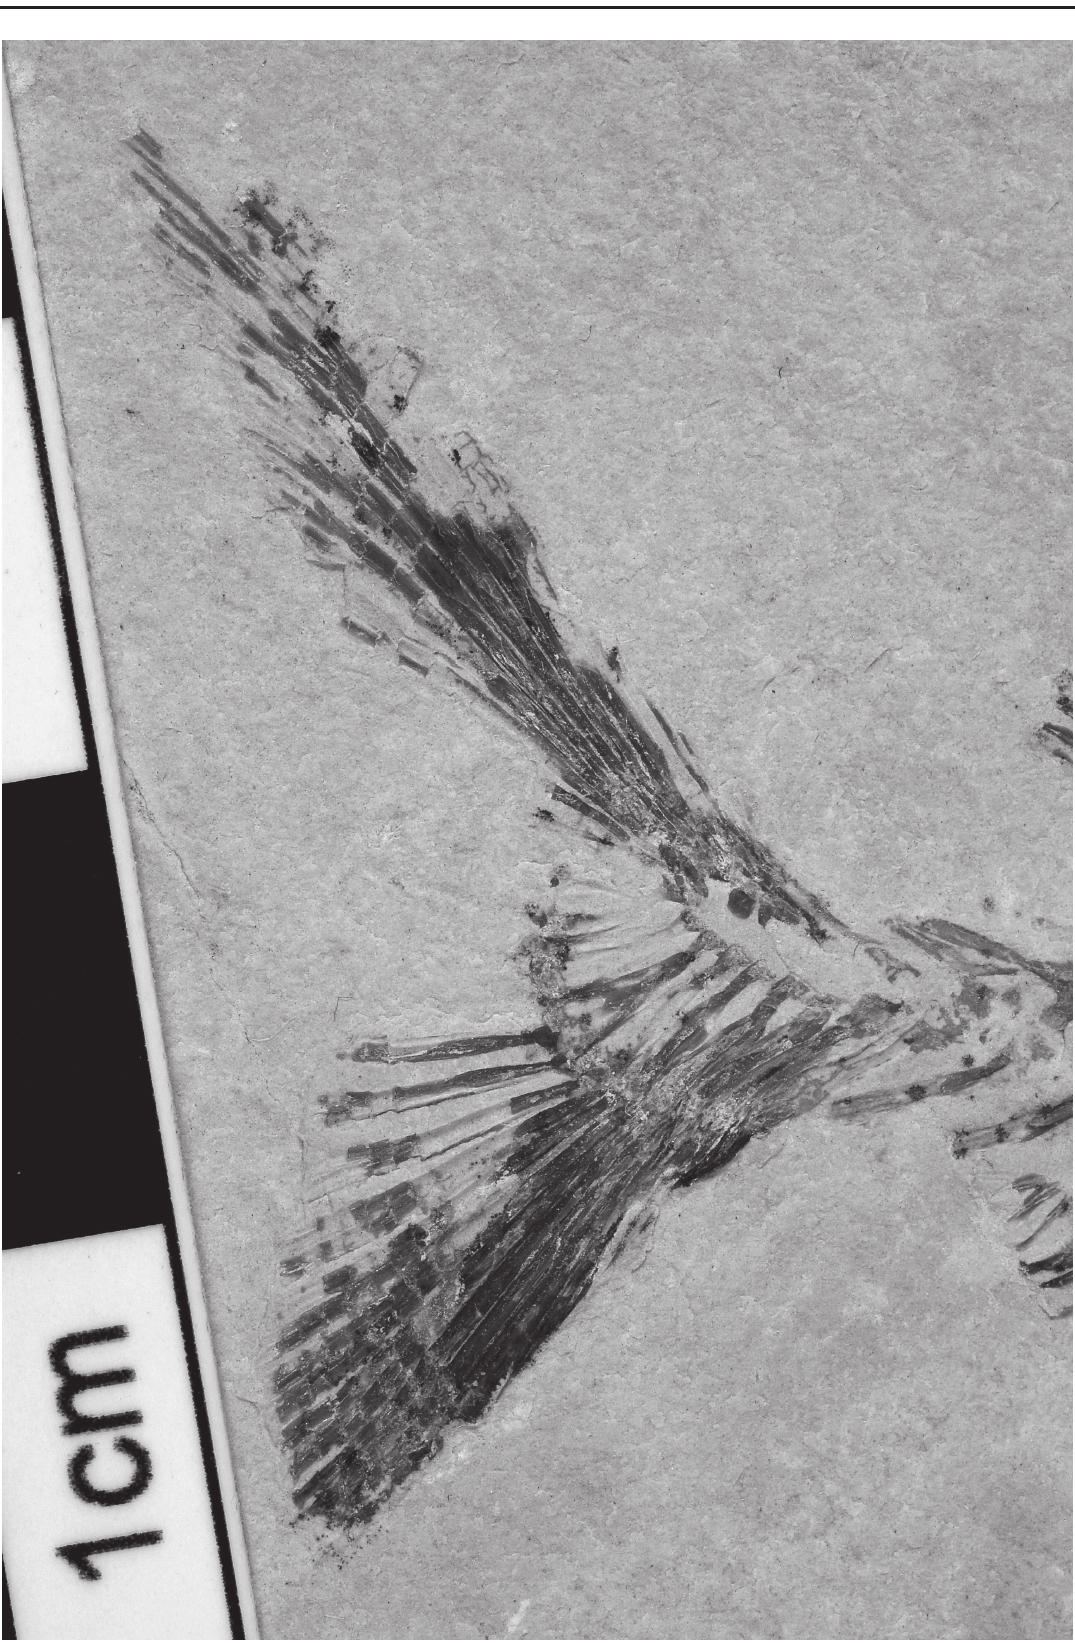
Fig. 14. Acrorhinichthys poyatoi gen. et sp. nov. Caudal region of the holotype